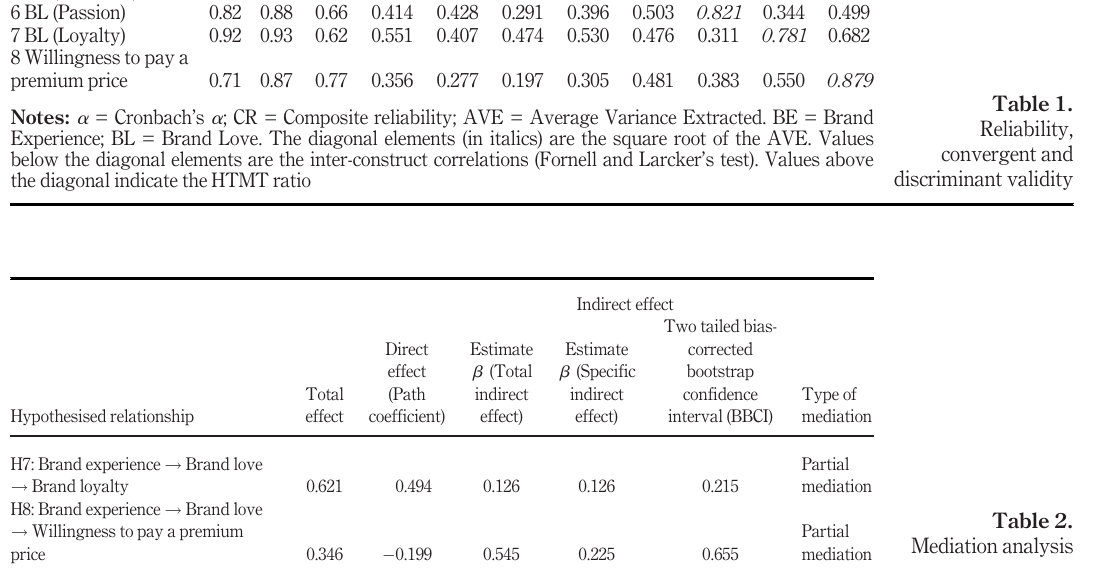
Table 2. Mediation